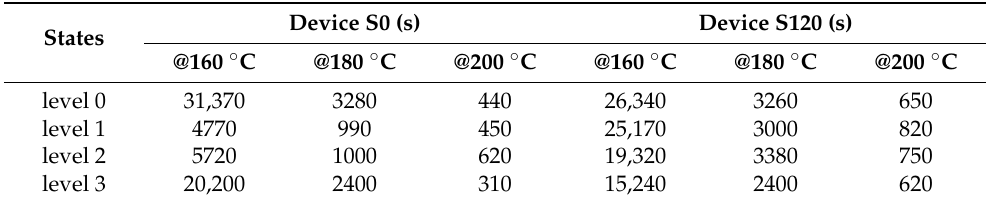
Figure 5. Room temperature data retention of four storage states for ( a ) device S0 and ( b ) S120; dependence of resistance on time at high temperatures for ( c ) devices S0 and ( d ) S120; temperature dependence of retention-failure-time fitting lines following the Arrhenius equations for ( e ) devices S0 and ( f ) S120. Table 1. Retention failure times of resistance states.